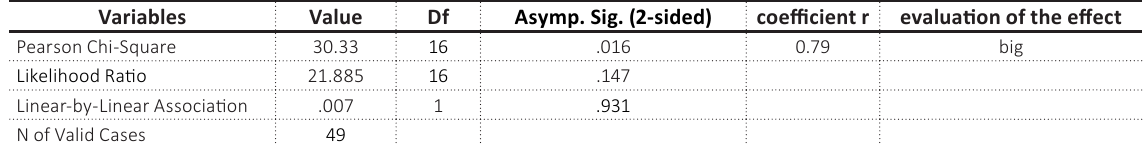
Table 6. Evaluation of the connection between the type of hospitals and the position of those responsible for clinical risk